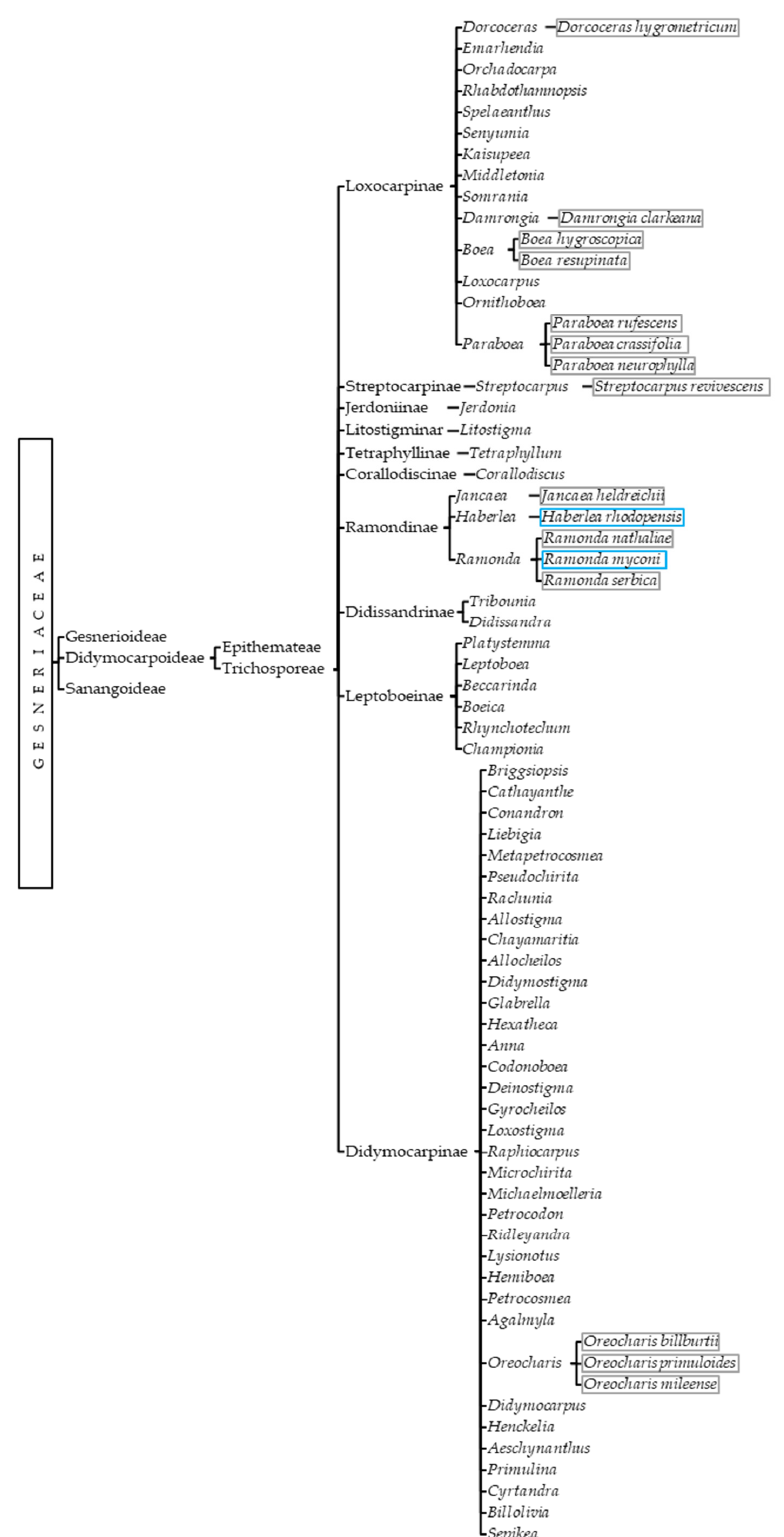
Figure 2. Current phylogenetic classification of Didymocarpoideae with resurrection (grey squares) and double-tolerant (blue squares)